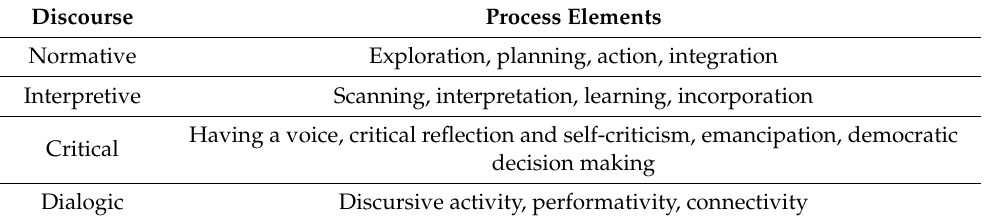
Table 1. Process elements in the different